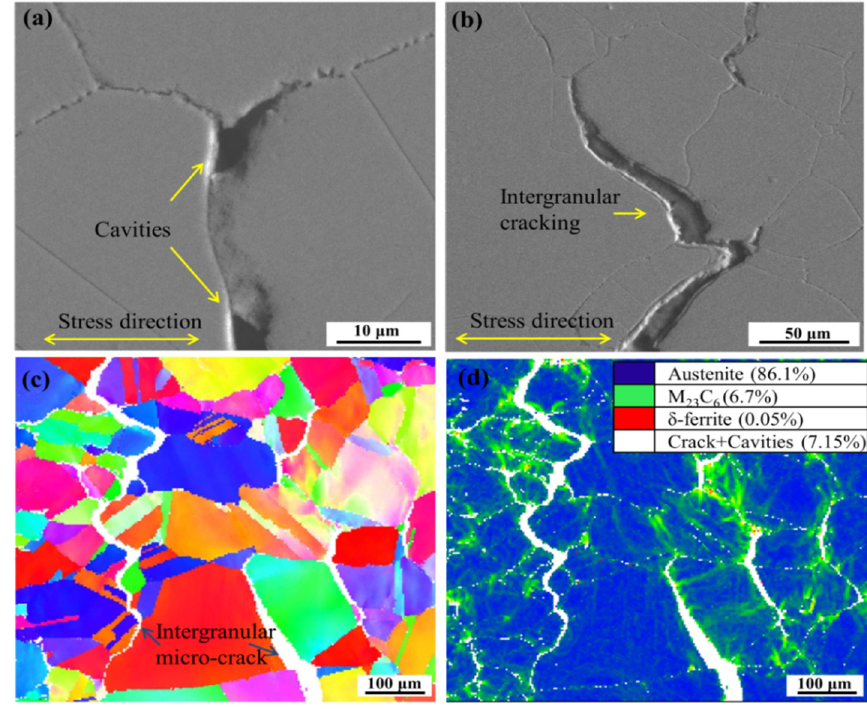
Figure 7. Microstructure near creep rupture: ( a ) cavities; ( b ) intergranular cracking; ( c ) EBSD analysis of intergranular crack; ( d ) phase distribution of ( c ).